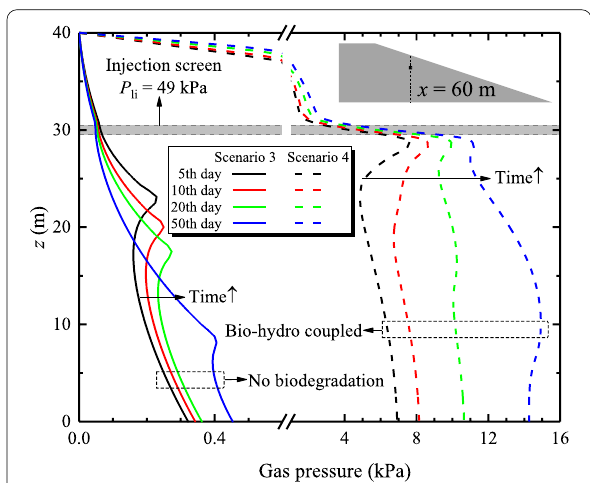
Fig. 4 Gas pressure profiles of different scenarios at x different times